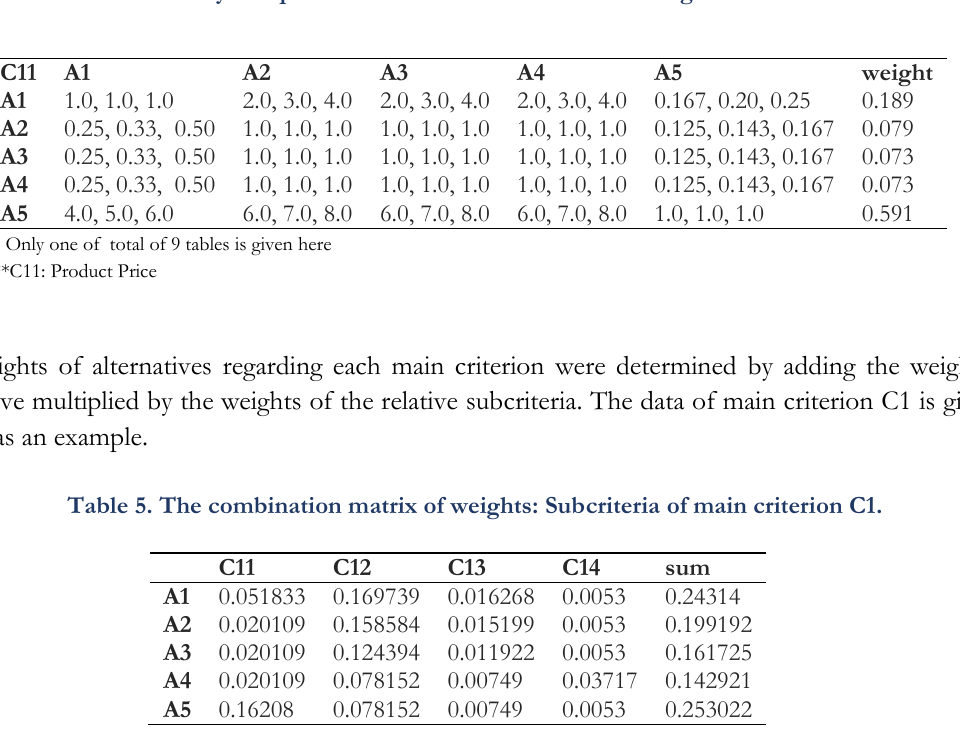
* Only one of total of 3 tables is given here. C1: Cost. Table 4. The fuzzy comparison matrix of the alternatives in regard to subcriterion C11.*